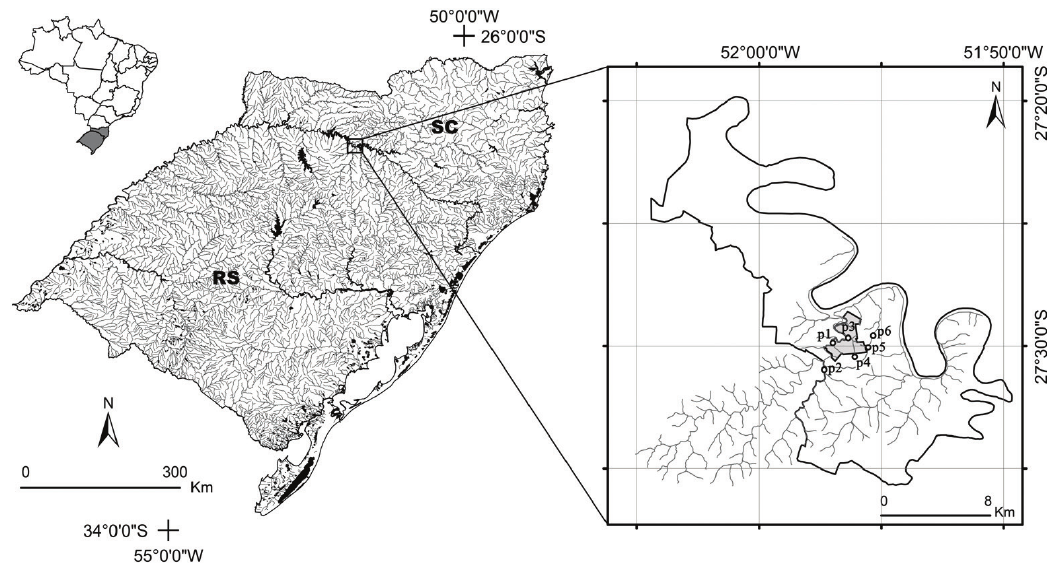
Figure 1. Locations and distribution of the sampling sites within and outside the Mata do Rio Uruguai Teixeira Soares Municipal Natural Park (PTS), situated in the northern region of the state of Rio Grande Do Sul, Marcelino Ramos, 2009 (Southern